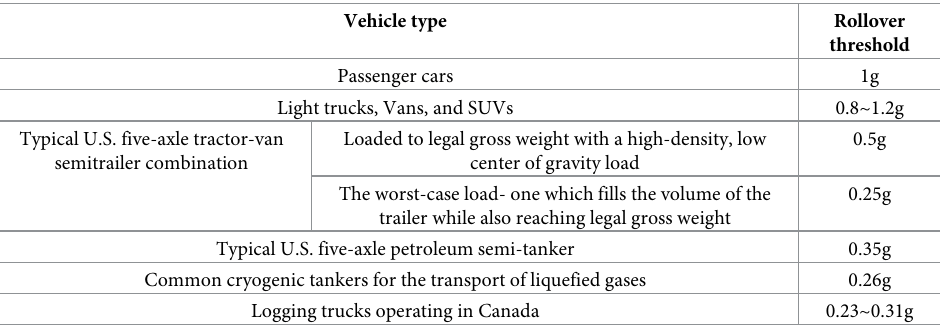
Table 1. Summary of the rollover threshold in existing